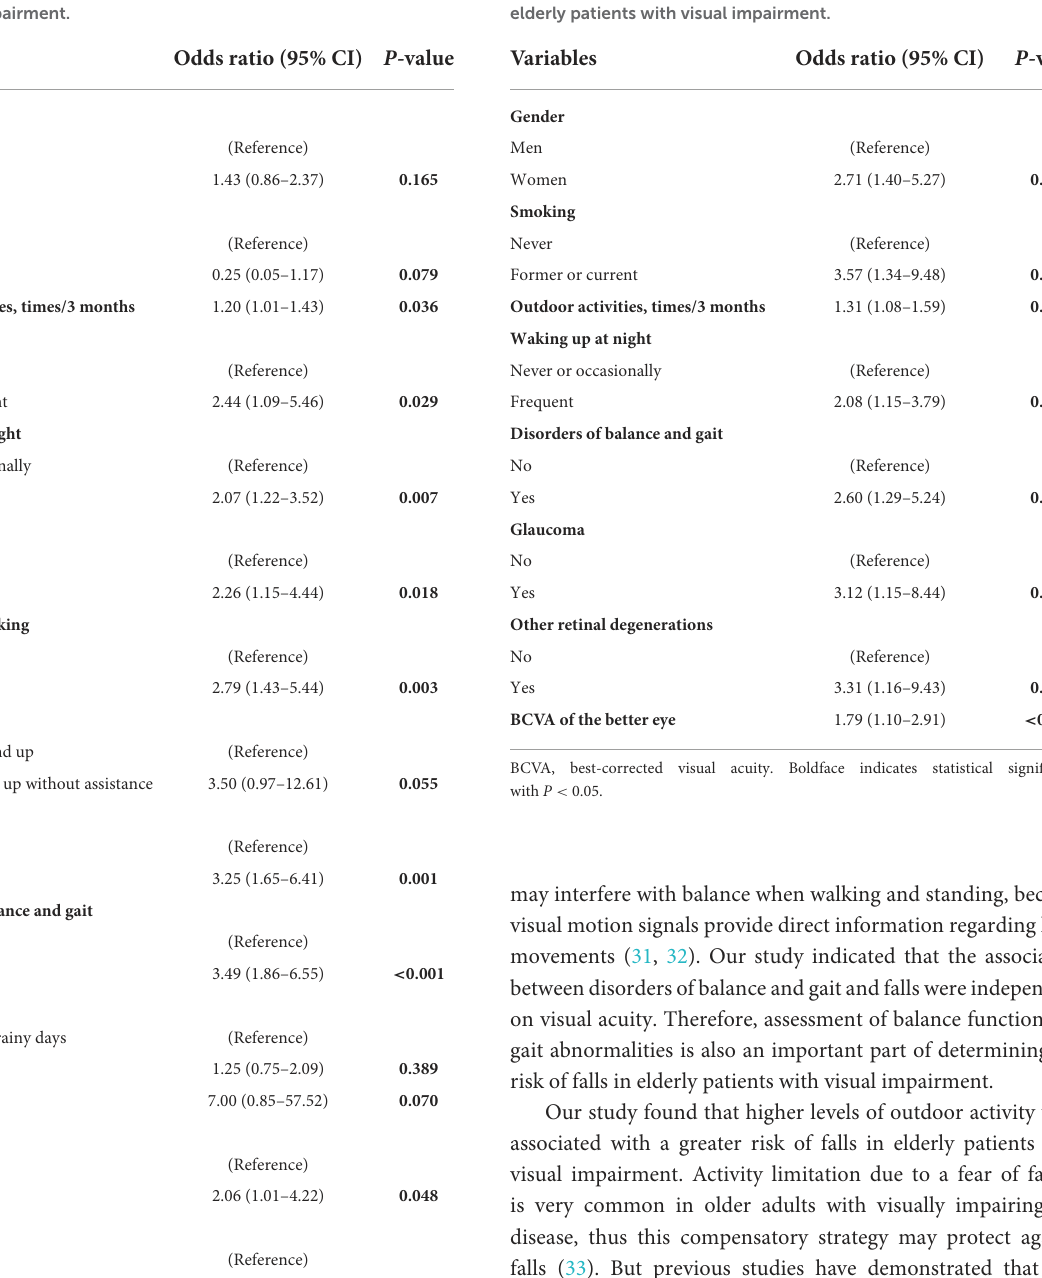
TABLE 3 Univariate logistic regression for fall risk in elderly patients with visual impairment.